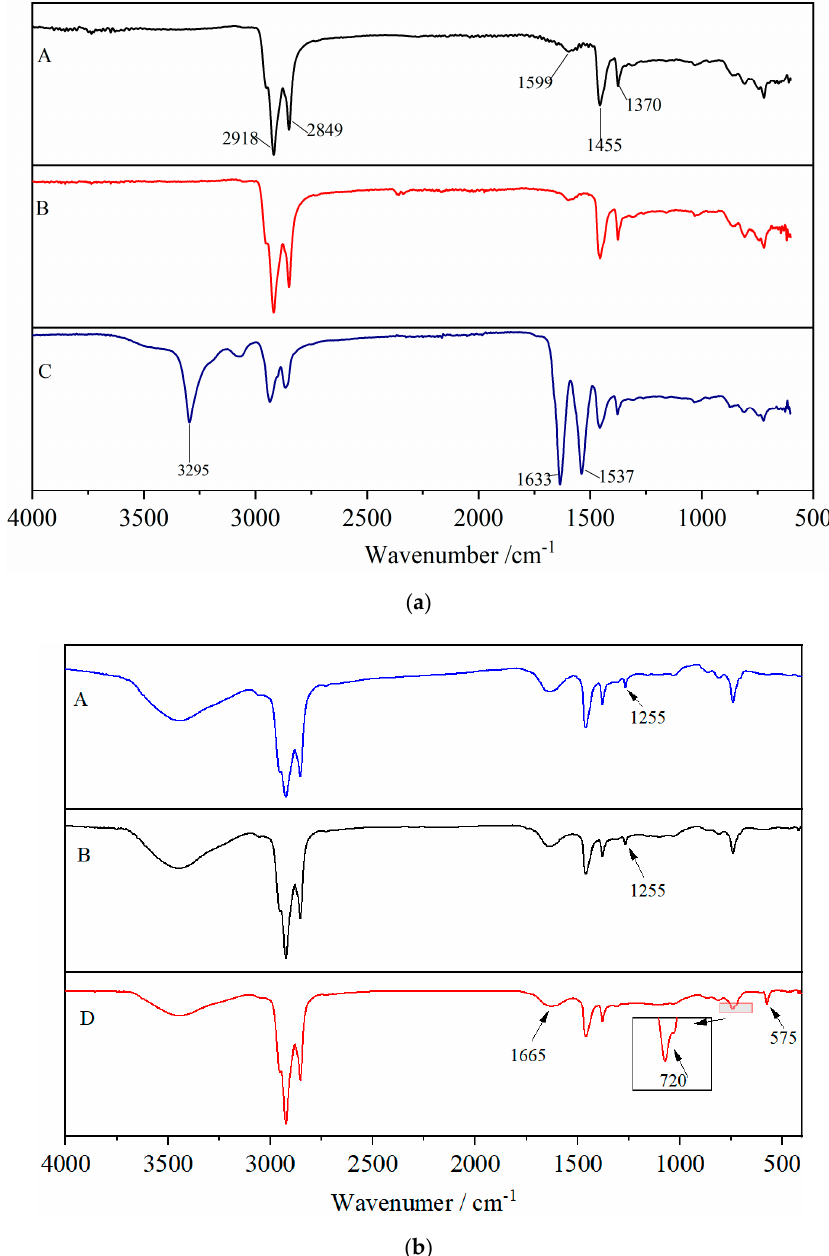
Figure 4. FTIR spectra of asphalt binders. ( a ) A- base asphalt binder, B- modified asphalt binder with unactivated rubber and C- modified asphalt binder with coating-activated rubber. ( b ) D- modified asphalt binder with grafting-activated rubber.